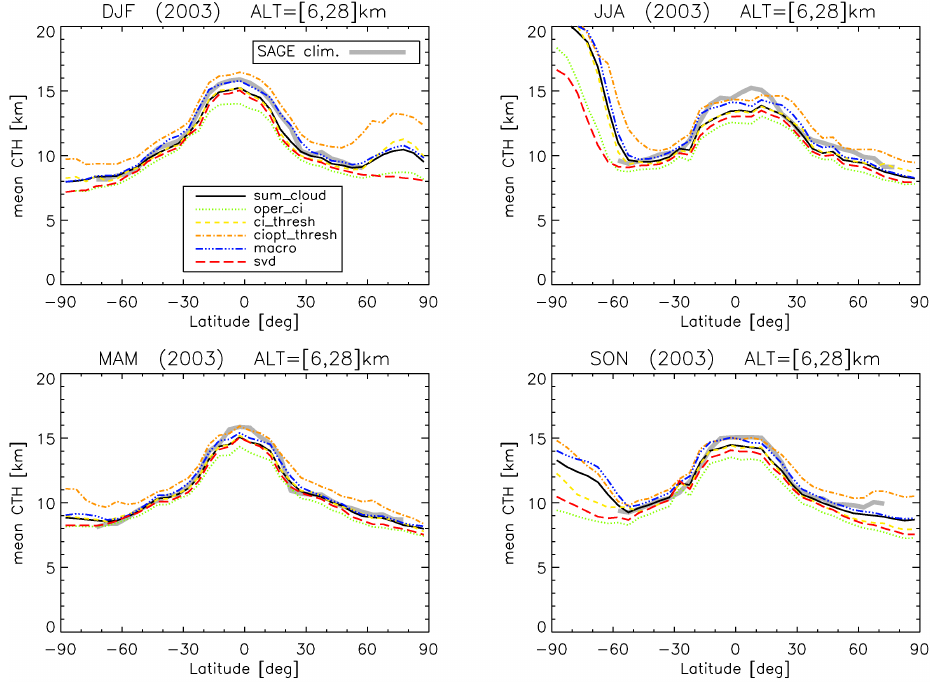
Fig. 12. The zonal mean CTH for various detection methods above 4km altitude for spring, summer, autumn and winter seasons in the 2002 (Dec) to 2004 (January–November) time period together with the corresponding SAGE II climatology distribution (for details see